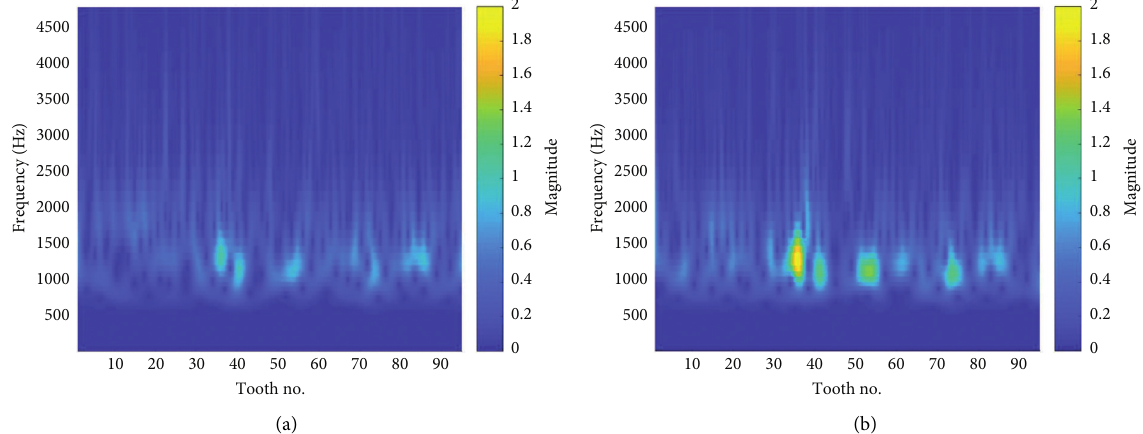
Figure 10: Wavelet analysis: (a) 700 hours and (b) 800 hours of experiment.